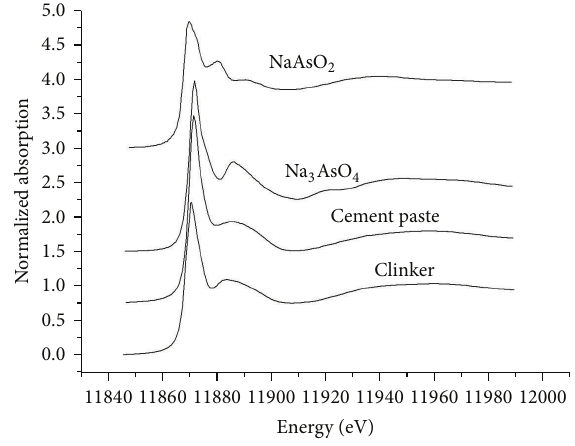
Figure 5: As K-edge XANES spectra for the samples and two standard compounds.